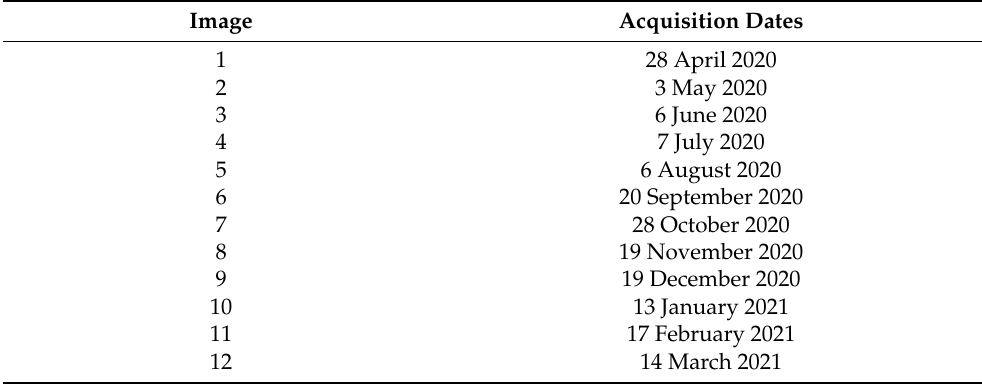
Table 3. Sentinel-2 satellite image acquisition